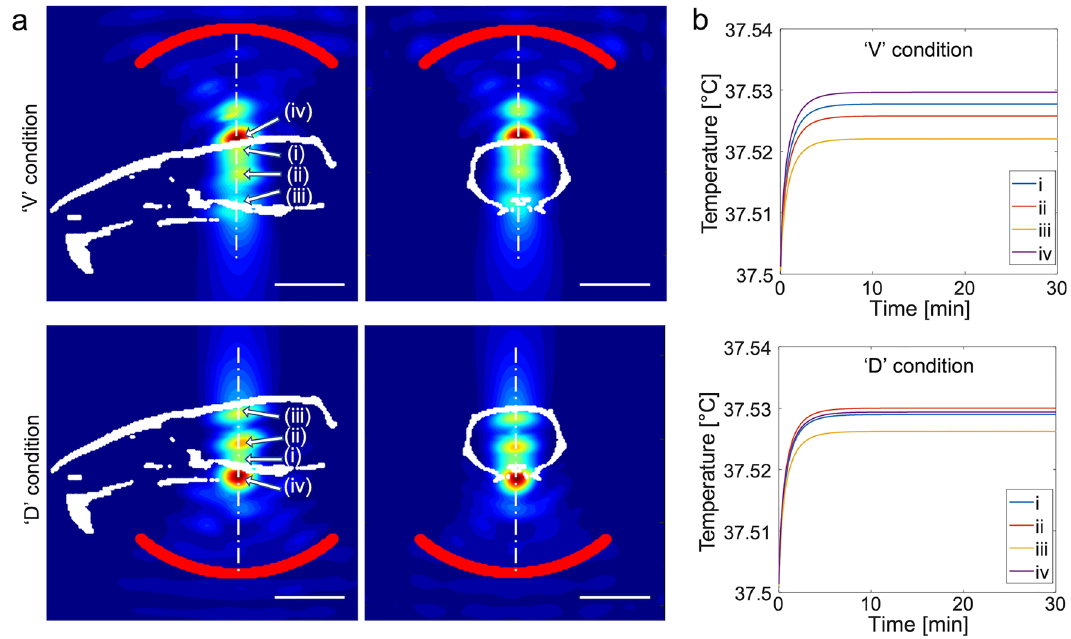
Figure 5. Numerical simulation of the acoustic propagation and thermal rise from different tissue locations. ( a ) Pseudo-colored relative acoustic intensity normalized with respect to the maximum value obtained from the numerical simulation of acoustic intensity along the plane of acoustic focus (obtained from one rat skull, outlined in a white cranial profile) from the ‘V’ and ‘D’ conditions. The profile of the transducer is marked by the red line. Bar = 10 mm. ( b ) Numerical estimation of tissue temperature at (i) the geometric acoustic focus, (ii) local maximum near the center of the brain, (iii) brain-skull interface opposite to the sonication path, as well as (iv) the skull surface facing the incident sonication.